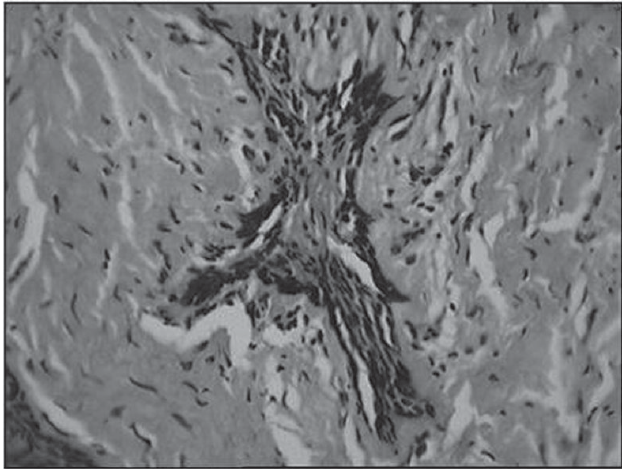
Fig. 4. Histological image showing irregular, bizarrely shaped odontogenic epithelial islands and cords in a moderately cellular fibrous connective tissue with abundant thick collagen fibers that appear to compress the odontogenic islands giving them a stellate or an “animal-like” configuration.